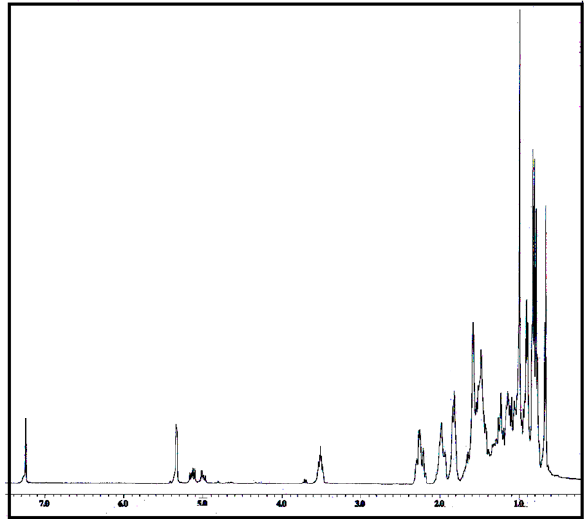
Figure 3: 1 H-NMR spectrum of